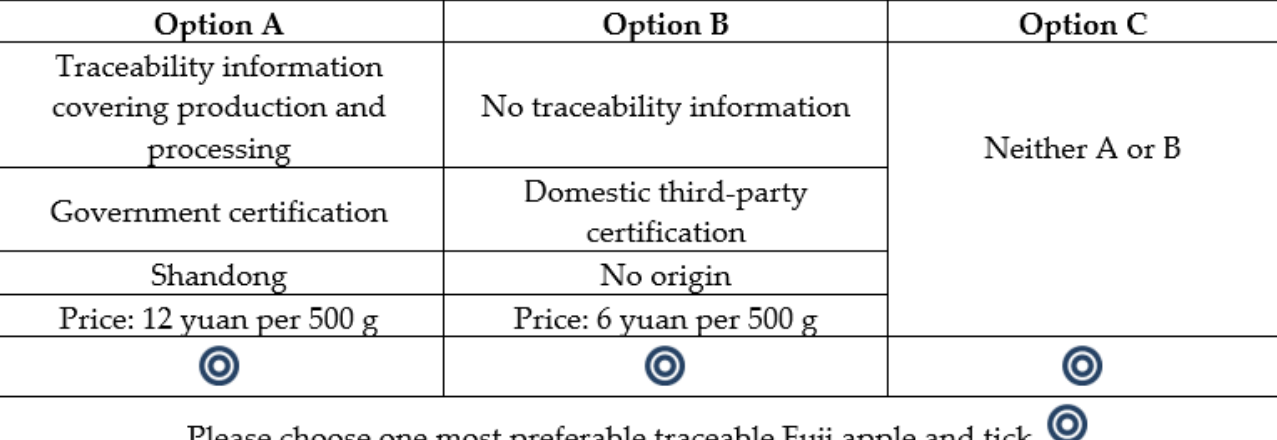
Figure 1. A sample choice task in the choice